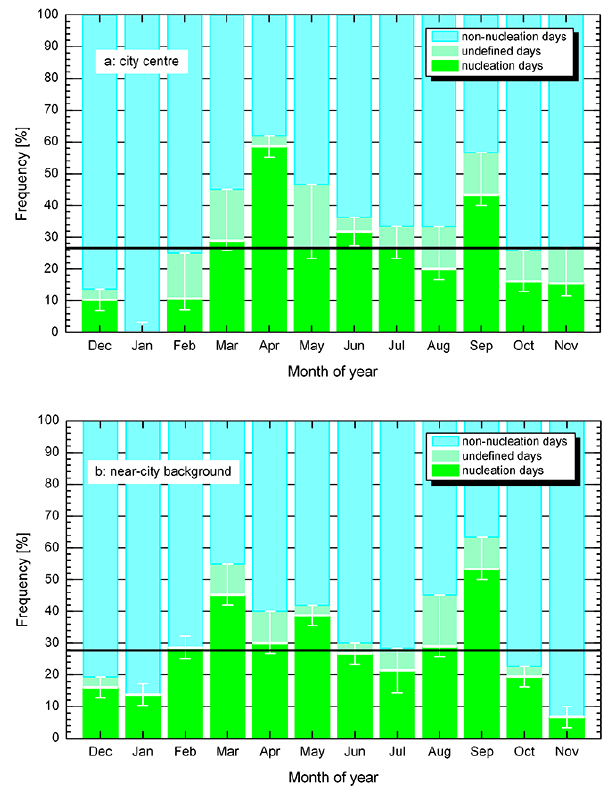
Figure 2. Monthly mean frequencies for days with new particle for- mation, undefined days, and non-event days in the city centre (a) and near-city background (b) . The horizontal lines indicate yearly mean frequencies. For explanation of the error bars, see the text.